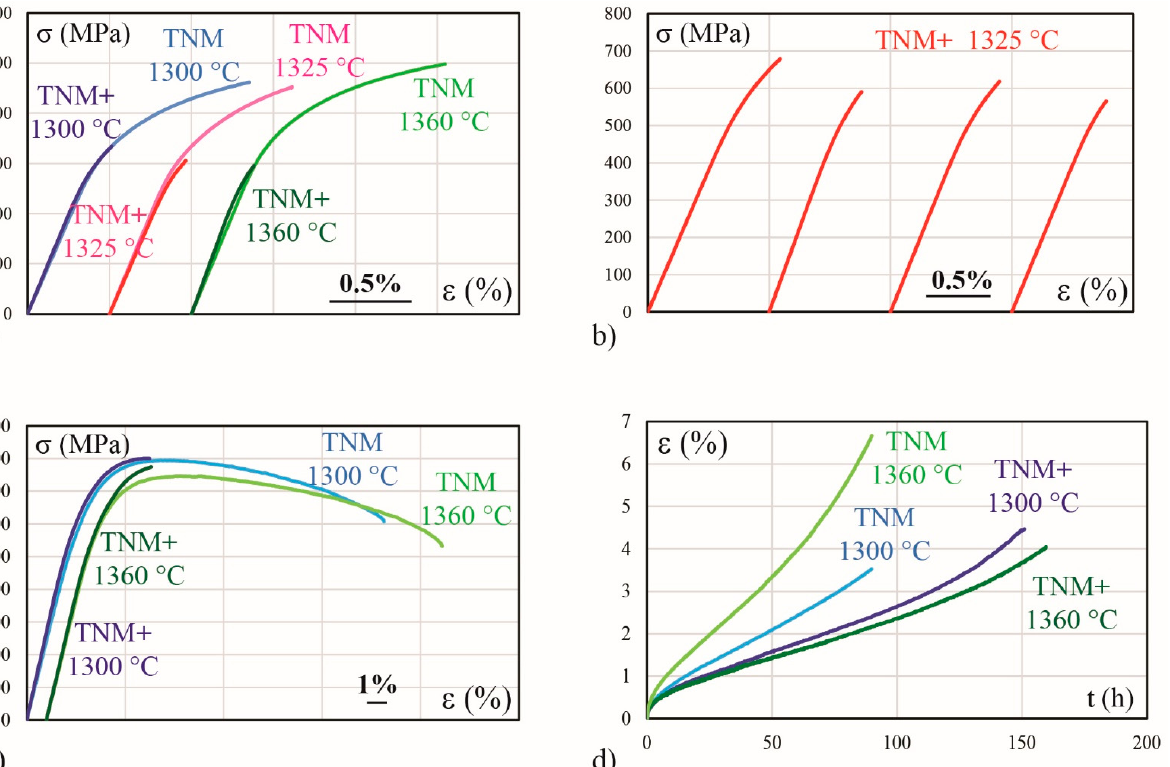
Figure 5. Mechanical properties of the TNM + and TNM alloys. ( a ) Comparison of the tensile tests at room temperature performed on the two alloys for three different dwell temperatures; ( b ) results of four tensile tests performed at room temperature on TNM + samples sintered at 1325 °C; ( c ) compar- ison of the tensile curves recorded at 800 °C for the TNM + and TNM alloys which were densified at different dwell temperatures; and ( d ) creep curves at 800 °C under 200 MPa. All temperatures indi- cated in the diagrams are the dwell temperatures used for the densification of the corresponding material. The tensile curves are shifted by 0.5% or 1% so that they differ from each other. Both SEM fractographic and EDX chemical analysis were carried on TNM + tensile samples after rupture at room temperature, in order to identify the origin of the low duc- tility of this alloy. Figure 6 shows the fracture surface of a sample sintered at a dwell tem- perature of 1325 °C. The SEM images obtained at different magnifications with secondary electrons allow the identification of the initiation site (marked in the dotted circle in Figure 6a) and indicate a predominantly transgranular crack propagation with the presence of facets at the lamellar interfaces (Figure 6b), as observed on TNM alloy samples [13]. Figure 6c–e displays a more precise local analysis of the centre of the crack initiation site, zoomed in Figure 6b. Figure 6c, obtained with back-scattered electrons, evidences a clear delimitated area characterized by light grey zones around a black centre. The local chemical analysis reveals that this delimitated area exhibits an enrichment in Fe, clearly visible in Figure 6d. Figure 6e indicates the presence of smaller and localized zones rich in Si. Other chemical maps not reproduced here; notably, Mo and Nb show no evidence of other local chemical enrichments. The local chemical difference lays principally in the presence of Fe, an element not present in the nominal composition of the TNM + alloy and necessarily the result of a pollution introduced during the atomization process or origi- nally present in the ingots used for the atomization. The other particularity of this particle is the black contrast in the middle, which was identified by means of SEM as cavities. Similar fracture surface investigations were performed in three other samples and in all of them such Fe contaminated areas were found as the location of the fracture initiation.